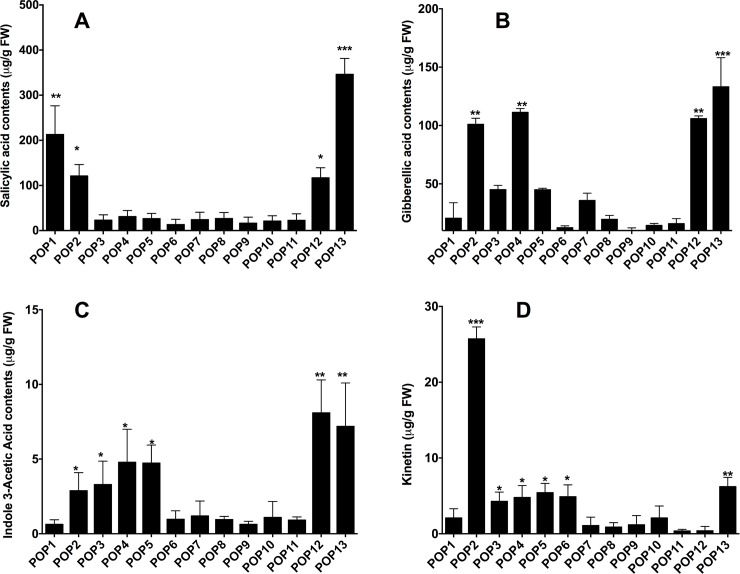
Endogenous phytohormonal quantification.Phytohormonal quantification (IAA, SA, Kinetin and GA) throught advanced chromatographic and spectroscopic techniques such as LC-ESI-QTOF and GC-MS/SIM. The values are representative of three replications with standard error. One-Way ANOVA analysis were performed with repeated measures using Tukey test by GraphPad Prism 6.01v (USA). *** showed values are p<0.0001; ** showed values are p<0.001; * showed values are p<0.05.